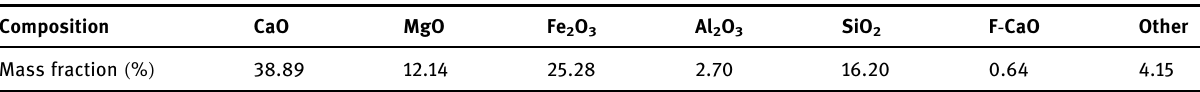
Table 5: Chemical composition of